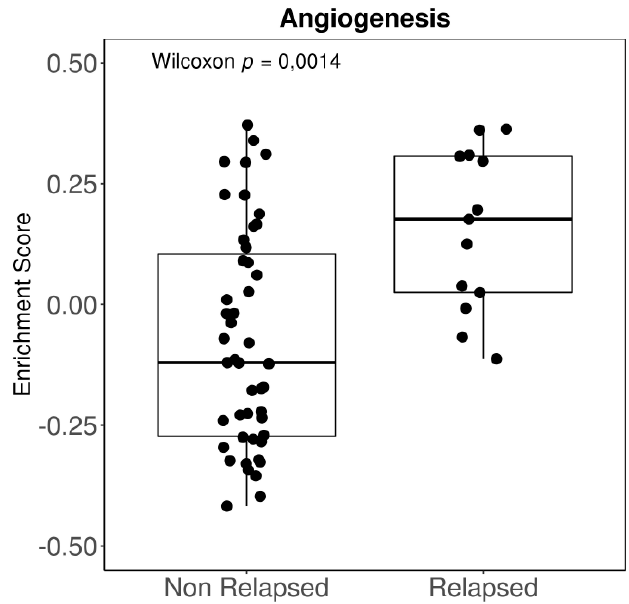
Figure 1. Angiogenesis enrichment score comparing relapsed vs. non-relapsed tumours. Scores were generated from expression data by gene set variation analysis (Gene Set Variation Analysis (GSVA) function). The gene set “Biocarta VEGF Pathway” from MSigDatabase (which includes genes related to hypoxia, blood vessels formation, and pro-angiogenic factors) was used (http://software.broadinstitute.org/gsea/msigdb/cards/BIOCARTA_VEGF_PATHWAY). Groups were compared by non-parametric Wilcoxon rank test. Data were extracted from The Cancer Genome Atlas (TCGA) database through cBioPortal (TCGA-UVM, 80 primary samples); expression data were downloaded as normalized Fragments Per Kilobase of exon per million fragments Mapped (FPKM) values and log2 transformed. VEGF: vascular endothelial growth factor.